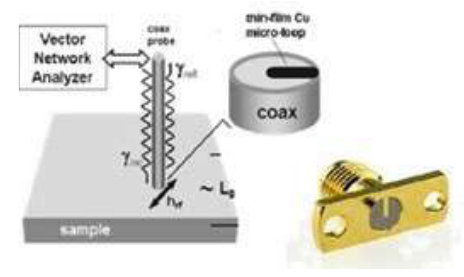
Figure 1: Schematic of the coaxial short circuited probe and equivalent